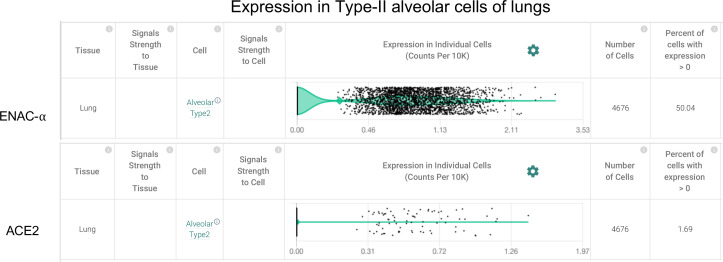
Type-II Alveolar cells of the lungs express ENaC-ɑ (SCNN1A) and ACE2 (Primary data processed from Pubmed ID: 31892341 and hosted on https://academia.nferx.com/).